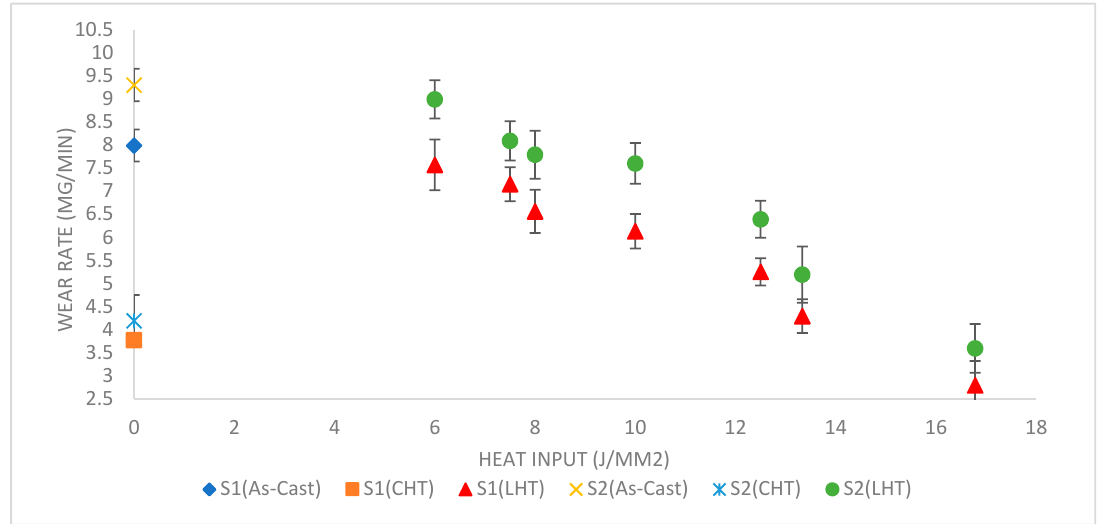
Figure 17. Wear rate behavior of as-cast, CHT and LHT S1 and S2 samples. Error bars represent standard deviation.